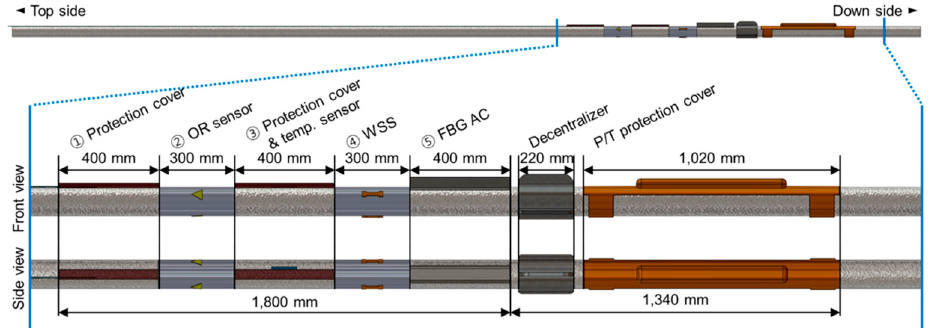
Figure 2. Front and side view of sensor casing design schematic.